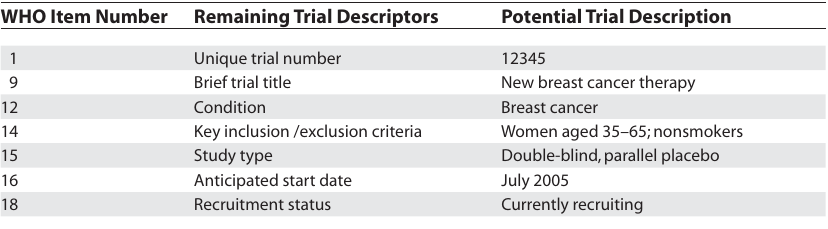
Table 2. An Imaginary Breast Cancer Study with Only the Remaining Trial